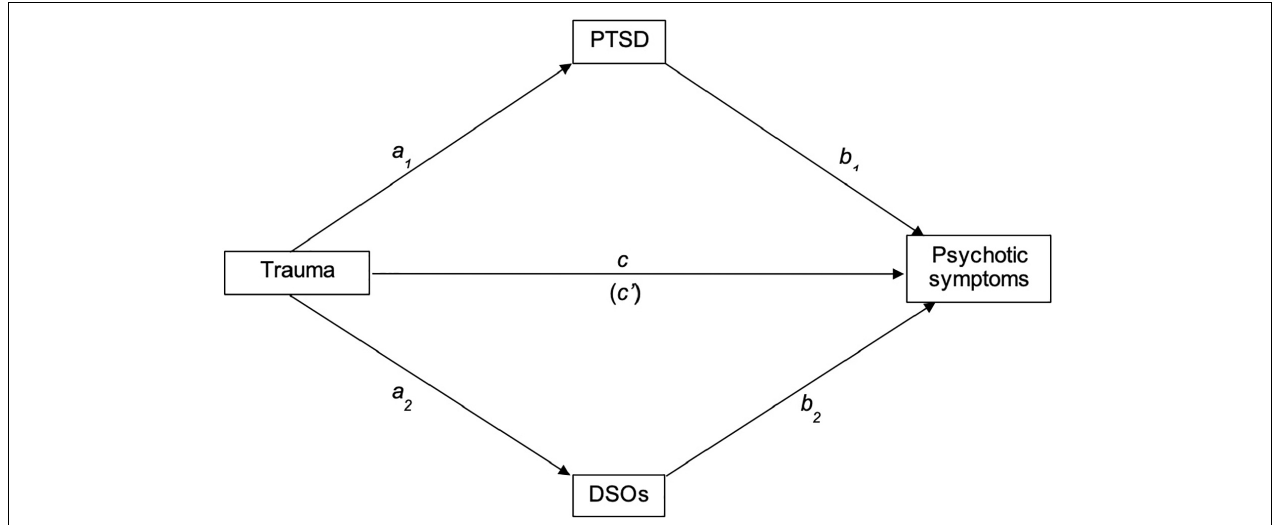
FIGURE 1 | Proposed path of the relationships between trauma, PTSD, DSOs and psychotic symptoms. PTSD, Post-traumatic stress disorder; DSOs, Disturbances of self-organization.